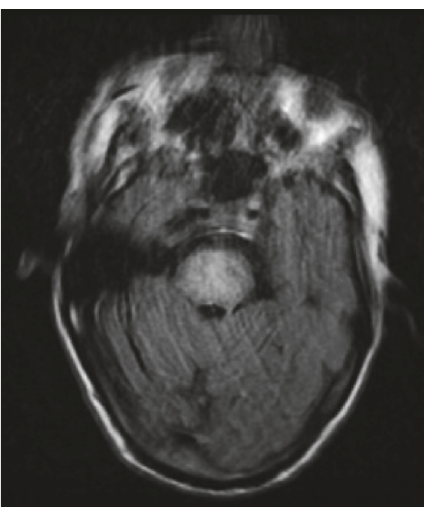
Figure 2: Magnetic Resonance Imaging of the brain without contrast showed high T2 signal and low T1 signal with restricted diffusion along with sparing of the bilateral peripheral pons, classic for central intrapontine, and extrapontine